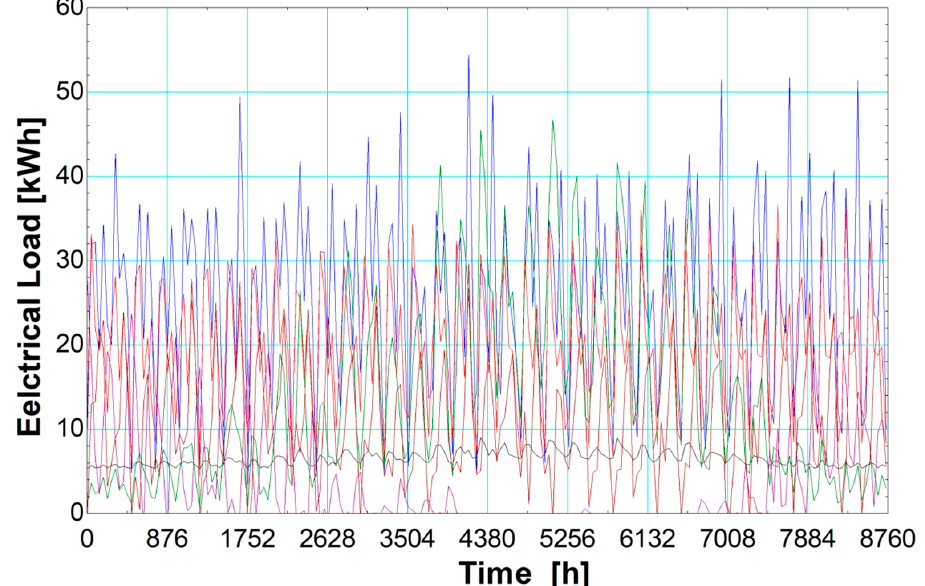
Figure 2. The load profile includes the following electrical loads (graph color in parenthesis): Fans (black), interior equipment (blue), interior lights (red), space cooling (green), space heating (purple), and domestic hot water (brown).